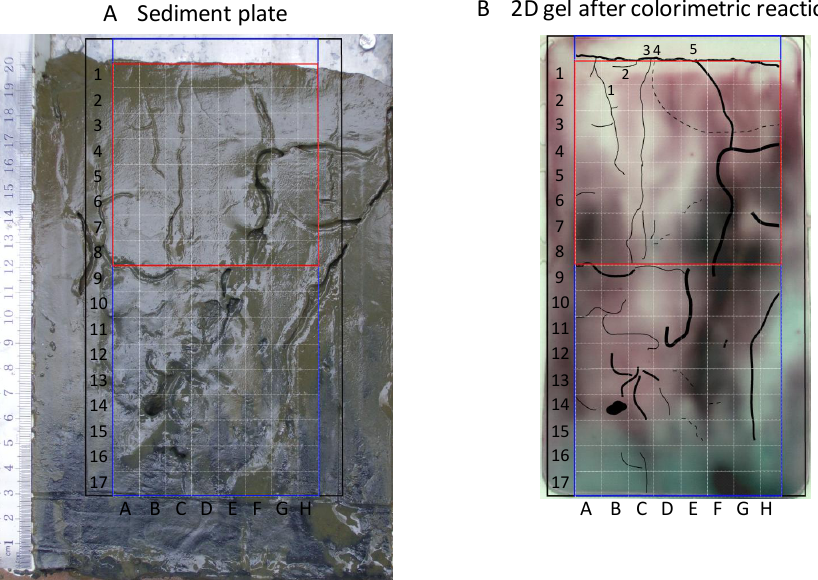
Figure 4. (a) Picture of the sediment plate before cube slicing for foraminiferal analysis (sediment–water interface at the top). (b) Picture of the analysed gel after colorimetric reactions: dissolved iron shown in dark pink and dissolved phosphorus in turquoise (burrows superim- posed). The black rectangle corresponds to the gel limit, the blue rectangle to the limit of available data set of dissolved iron and phosphorus and the red rectangle to the limit of the available data set of foraminiferal distribution.